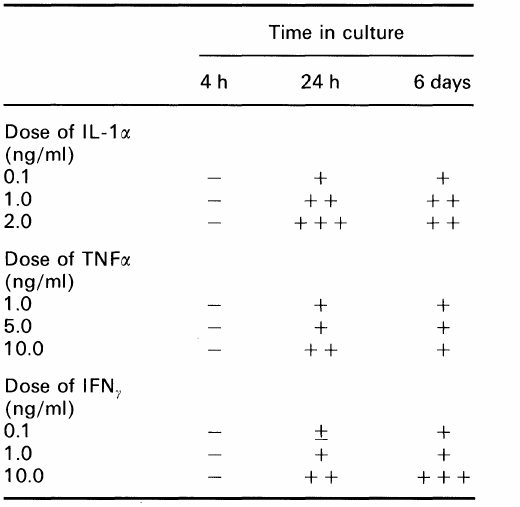
Table 1. Dose-response and time-course of induc- tion of ICAM-1 by cytokines on chondrocytes in normal human cartilage*